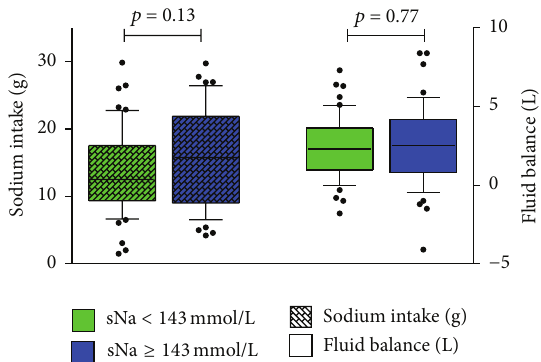
Figure 1: Total sodium intake and fluid balance 48 hours after admission in patients with and without developing IAH. sNa: serum sodium